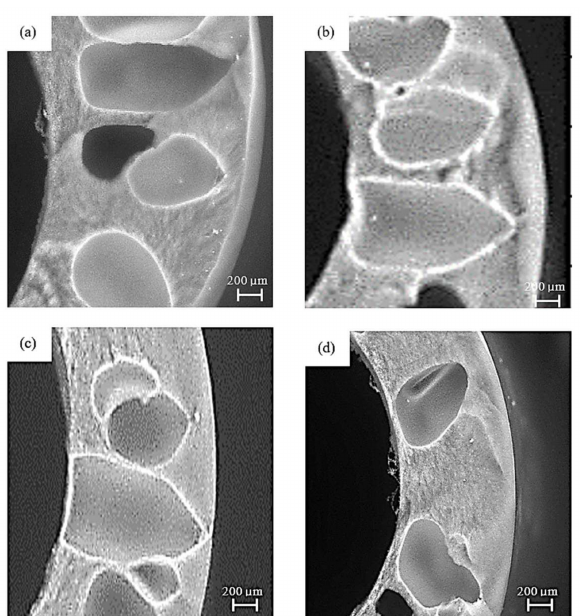
Figure 3. SEM cross-sectional images of NH 2 -MIL-125(Ti)/CTA HFMMM spun at different air gap distances of ( a ) 1 cm, ( b ) 3 cm, ( c ) 5 cm, and ( d ) 7